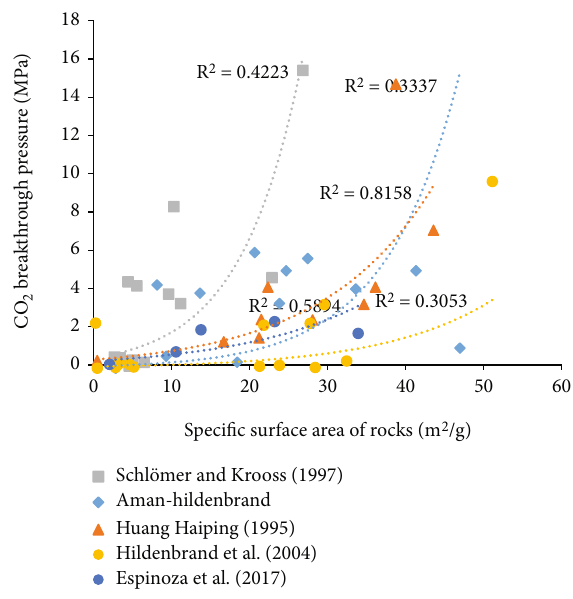
breakthrough pressure and